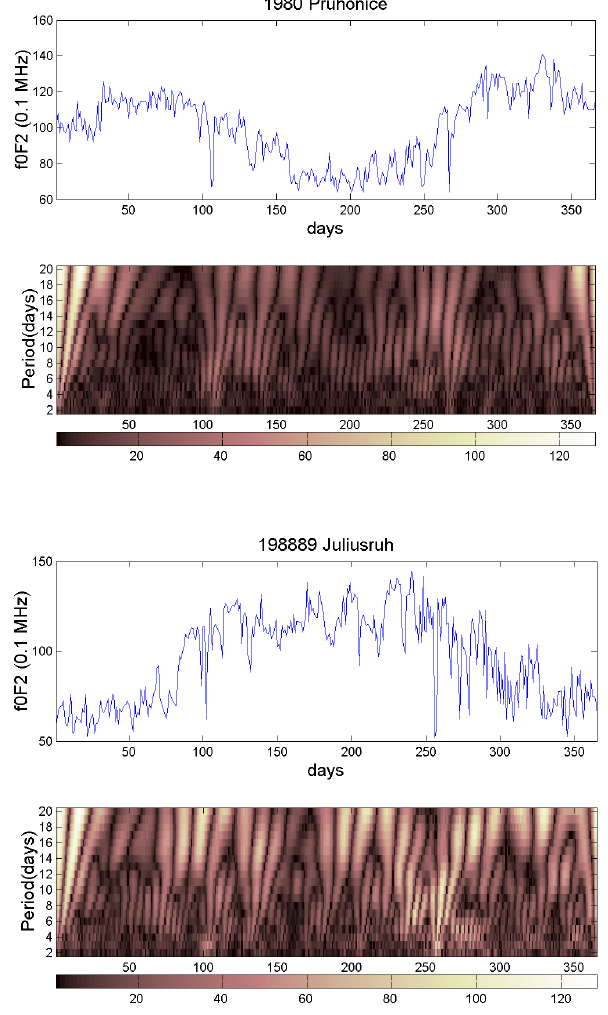
Fig. 2. Planetary wave activity in- ferred from fo F2 for Juliusruh, July 1988–June 1989, Meyer wavelet trans- form. Top panel, time series of raw fo F2 data. Bottom panel, wavelet transform of the planetary wave activity changing by colour from black-brown (minimum values) to white (maximum values).